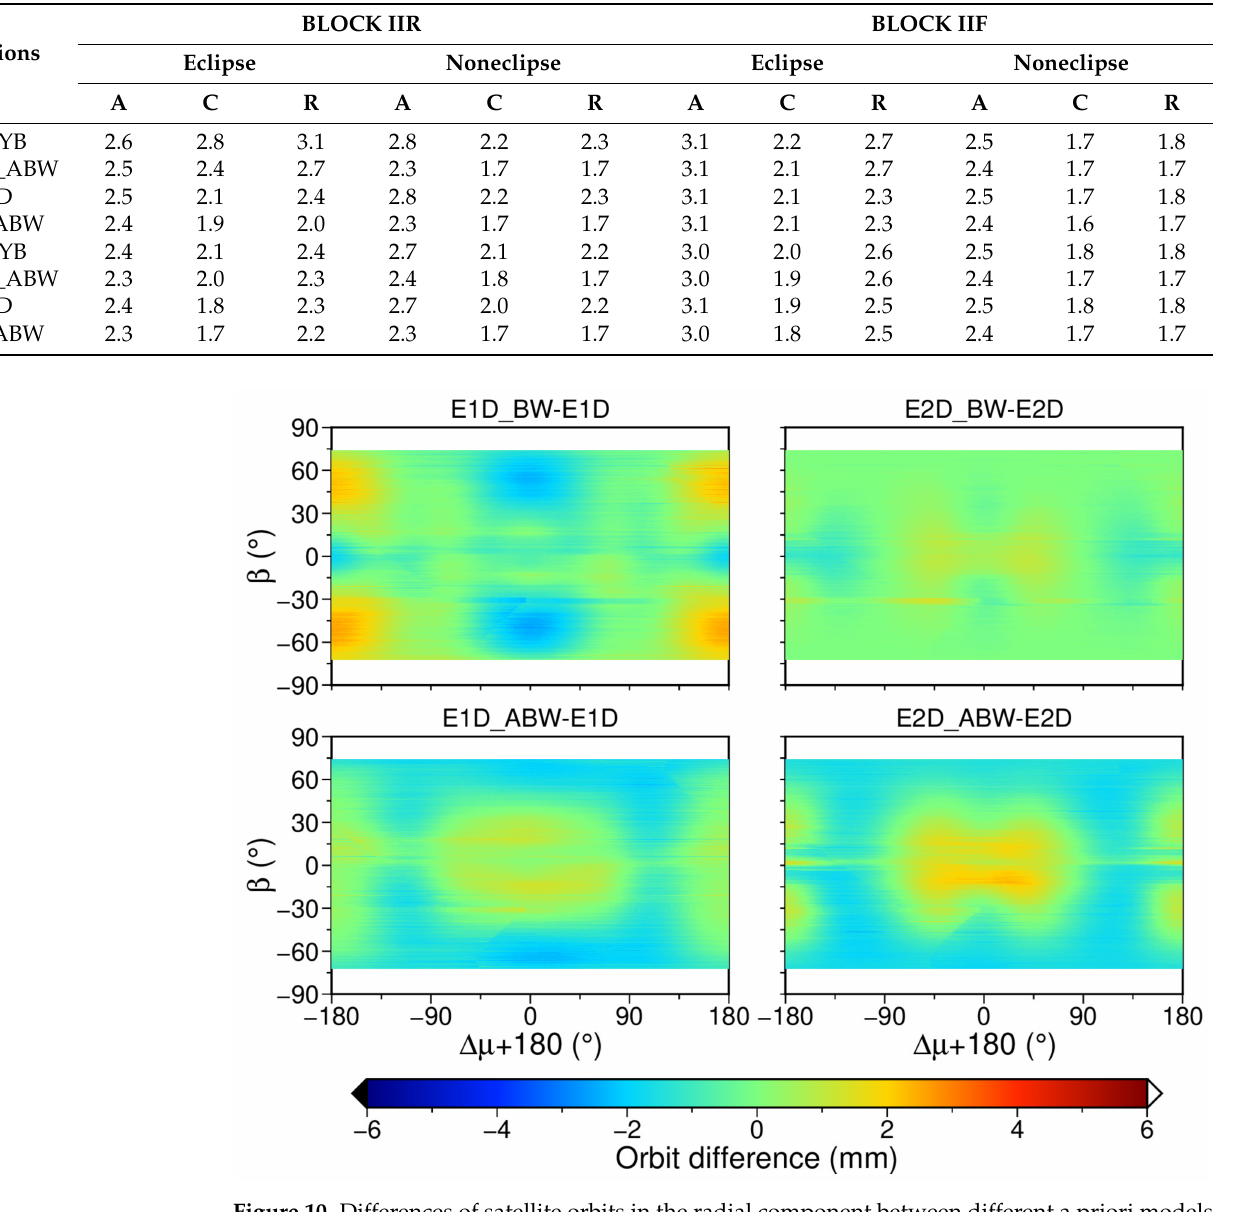
Figure 10. Differences of satellite orbits in the radial component between different a priori models for G073 (BLOCK IIF) as a function of β and ∆ µ angle in 2019. ∆ µ is the angular argument. Upper: differences between using no a priori SRP model and using the box-wing model; lower: differences between using no a priori SRP model and using the adjustable box-wing model. Left and right panels: using ECOM1 and ECOM2 as parameterization model,